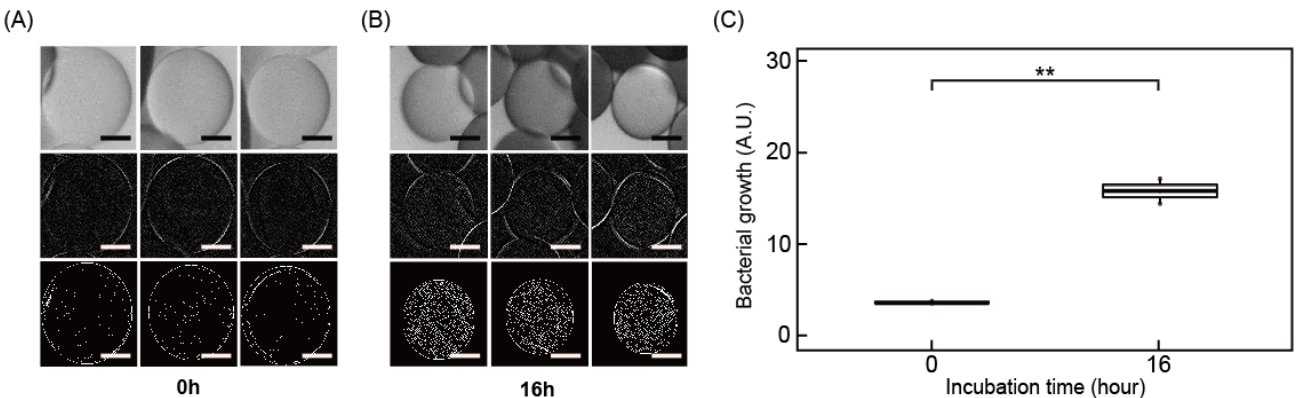
Figure 3. Image analysis of bacterial growth in droplets. Microscopic images of the droplet with bacterial cells at ( A ) the initial condition at a concentration of 10 6 CFU/mL and ( B ) the final condition after 16 h of incubation. ( C ) Measured bacterial growth of initial and final conditions. Scale bars represent 100 µm in ( A , B ).